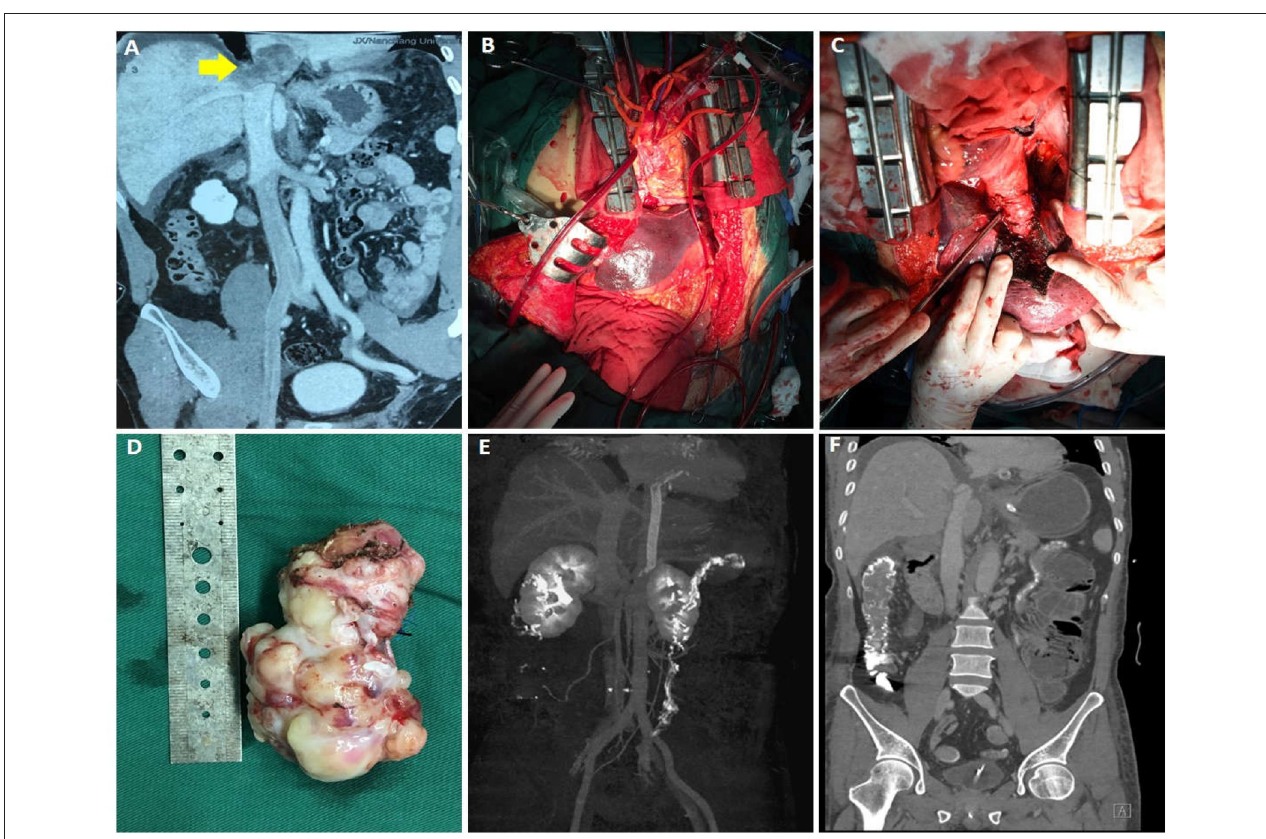
FIGURE 4 | Data of case 4 before, during, and during follow-up. (A) Preoperative CTV revealed that a mass invaded the second hilum and involved the hepatic vein. (B,C) During the operation, the liver was completely dissociated and the first hilum was controlled. The right atrium was cut open to separate the intraatrial mass, and then the mass at the second hilum was gradually dissociated. (D) An intact mass was removed. (E,F) Thirteen-day follow-up CTV revealed no residual mass or recurrence and the prognosis was good.